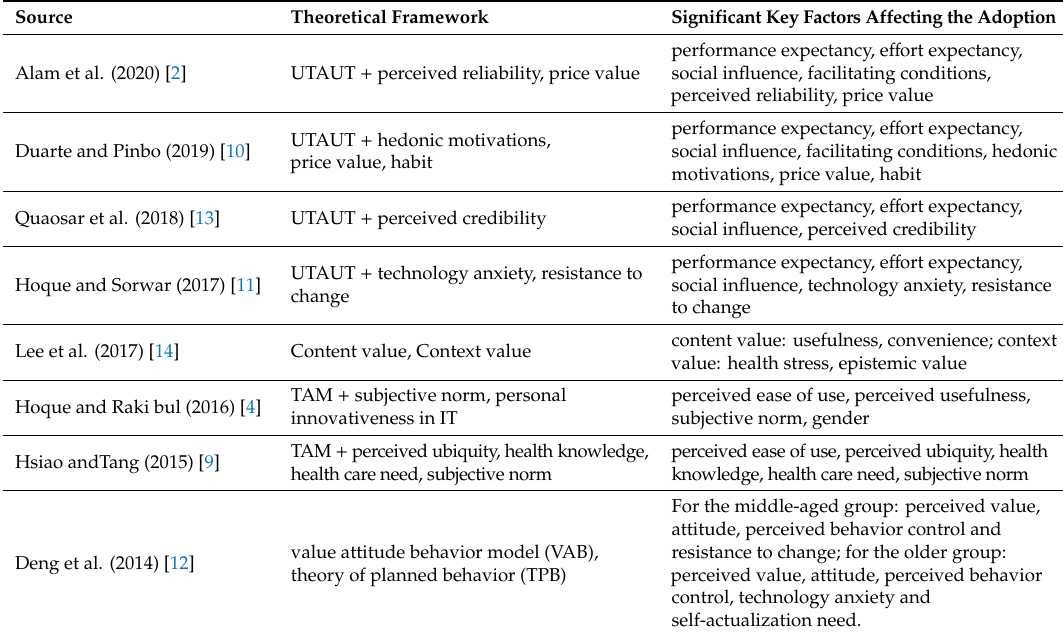
Table 1. Summary of the mobile health adopting